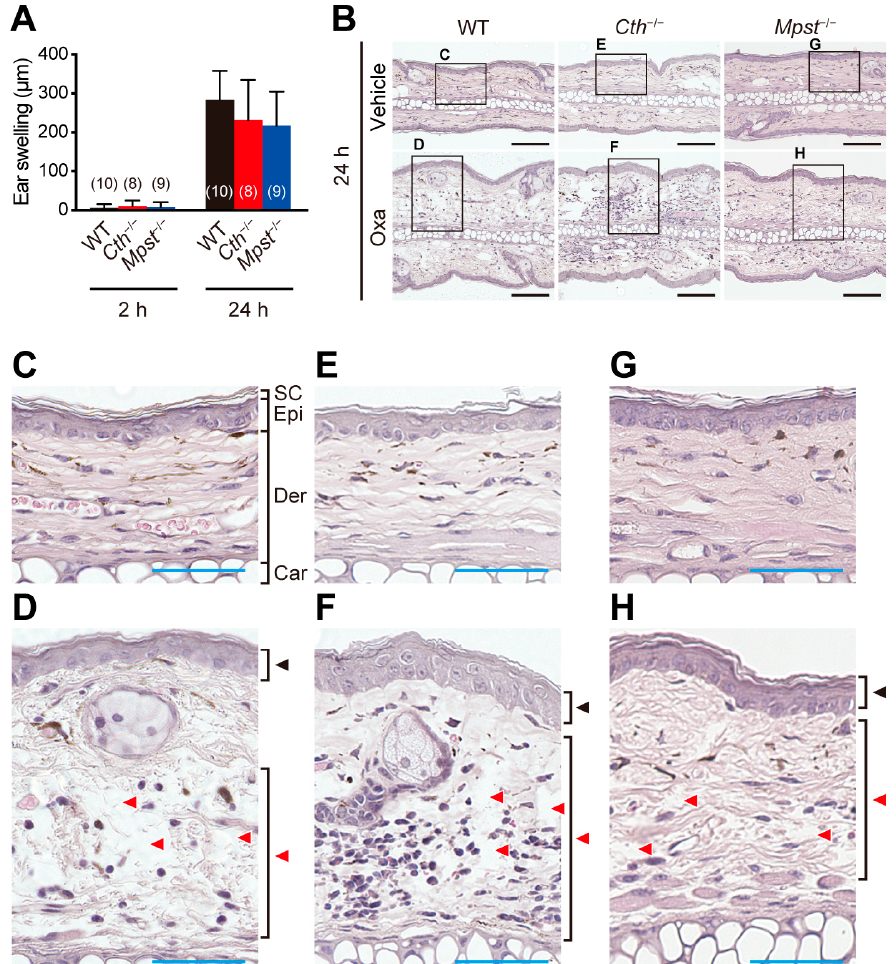
Figure 4. Oxazolone-induced contact dermatitis. Adult male wild-type (WT), CTH-deficient ( Cth –/– ), and MPST-deficient ( Mpst –/– ) mice were sensitized on the skin and then (7 days later) challenged with oxazolone (Oxa) on a single ear (another ear with the vehicle) to examine Th1/Th2-type allergic responses. ( A ) Increased ear thickness (the difference between oxazolone-treated right ear and vehicle-treated left ear) at 2 h and 24 h after oxazolone challenge. Data are the mean ± SD (sample numbers). ( B – H ) Typical section images of HE-stained sagittal sections of ears at 24 h after oxazolone challenge ( B ) with their magnified images ( C – H ). SC, stratum corneum; Epi, epidermis; Der, dermis; and Car, cartilage in ( A , B ). Black arrowheads indicate oxazolone-induced acanthosis, whereas red arrowheads indicate spongiosis ( D , F , H ). Bars indicate 100 µ m (black, B ) or 50 µ m (blue, C – H ). Quantitative reverse transcription-polymerase chain reaction (RT-PCR) analyses re- vealed no level changes in both CTH and MPST mRNA in the TNCB- and vehicle-treated ears of WT, Mpst –/– (without Mpst ), and Cth –/– mice (without Cth ) at the early phase (2 h) (Figure 5A,B). However, at the delayed phase (24 h), CTH mRNA was upregulated in the TNCB-treated ears of WT and Mpst –/– mice, whereas MPST mRNA was downregulated in the TNCB-treated ears of WT and Cth –/– mice (Figure 5C,D), suggesting protective roles of CTH against the delayed phase of TNCB-induced contact dermatitis. MPST downregula- tion was also found in the delayed phase (not the early phase) of oxazolone-treated ears of WT and Cth –/– mice (but not significant in Cth –/– ) (Figure 5E,F); therefore, MPST mRNA downregulation may not be implicated in the disease